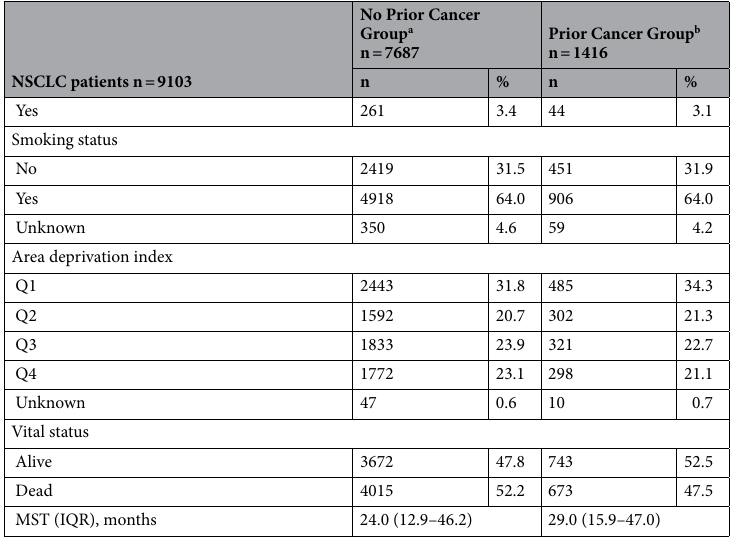
Table 1. Baseline characteristics of the patients according to prior cancer status. IQR Interquartile range, MST Median survival time, NSCLC Non-small cell lung cancer. a Patients without any history of prior cancer. b Patients with a history of prior cancer. c Incidental detection during follow-up examination for another disease.